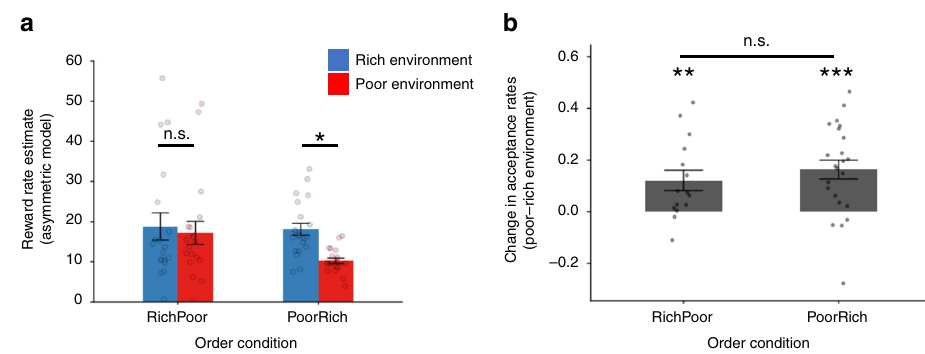
Fig. 4 Reward rate change and Experiment 3. a Extracting reward rate estimates ( ρ ) from the Asymmetric model for each participant in each experimental block in Experiment 1 (PoorRich group, N = 21; RichPoor group, N = 19) revealed signi fi cant environment by condition interaction ( F (1, 38) = 14.67, p = 0.000465). This arose out of a signi fi cant difference in ρ between environments for participants in the PoorRich condition ( t (20) = 8.64, p = 3.4864E − 8, two-tailed paired sample t -test) which was absent among participants assigned to the RichPoor condition ( t (18) = 1.16, p = 0.26, two-tailed paired sample t -test). b In Experiment 3, both groups of participants (PoorRich group, N = 23; RichPoor group, N = 15) signi fi cantly changed their acceptance rates between environments (RichPoor: t (14) = 3.07, p = 0.008; PoorRich: t (22) = 4.47, p = 0.000193, two-tailed one-sample t- test vs 0) and there was no longer any difference in the change in acceptance rates between RichPoor and PoorRich participants ( t (36) = 0.77, p = 0.45, two-tailed independent sample t -test). * p < 0.05, paired sample t -test; n.s. non-signi fi cant ( p > 0.05, two sided); ** p < 0.01, one sample t -test (vs 0, two tailed); *** p < 0.001, one sample t -test (vs 0, two tailed). Dots represent individual data points and bars represent the group mean. Error bars represent mean ± standard error of the mean. Source data are provided as a Source Data fi